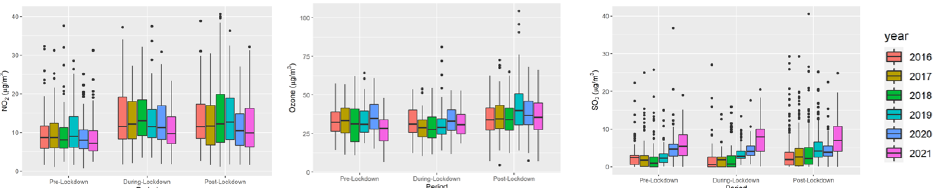
Figure 11. Comparison of NO 2 , ozone, and SO 2 for different periods from 2016 to 2021.